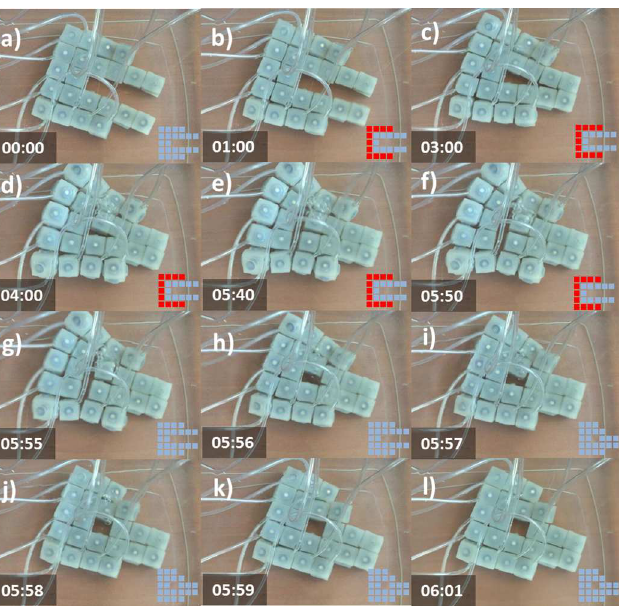
modulesare inflated (b) producinga closureof the shape(c). A delaminationbetweenfour central modules takes place at t = 5.4s (e). Deactivationof peripheralmodulesresults in migrationof a group of four modules toward the center (h-i) resultinginto a new stable configuration(j-l). Time stamps are in the format seconds: